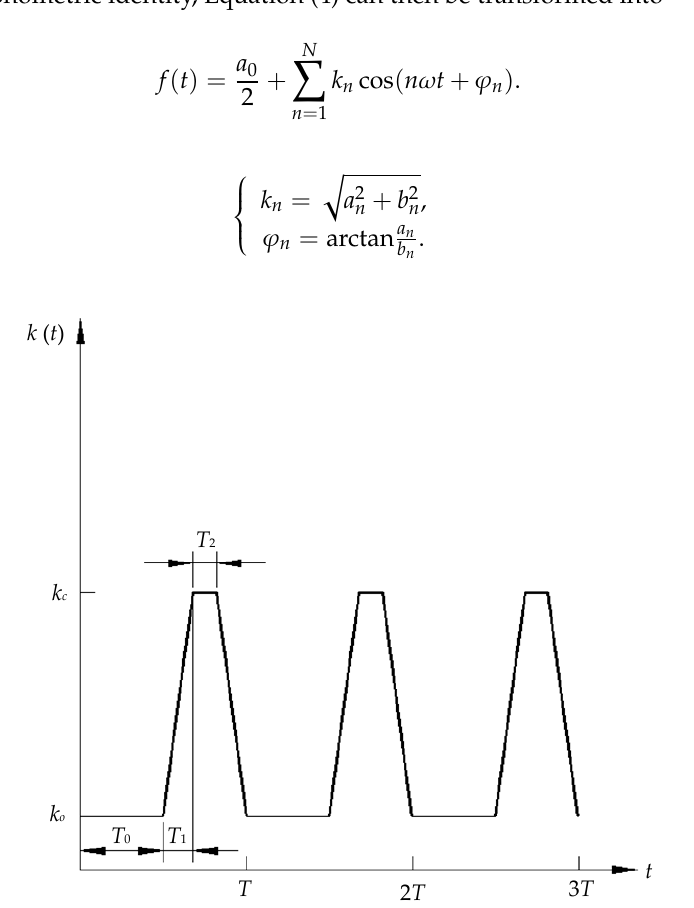
Figure 3. Bending stiffness variation of the cracked beam.